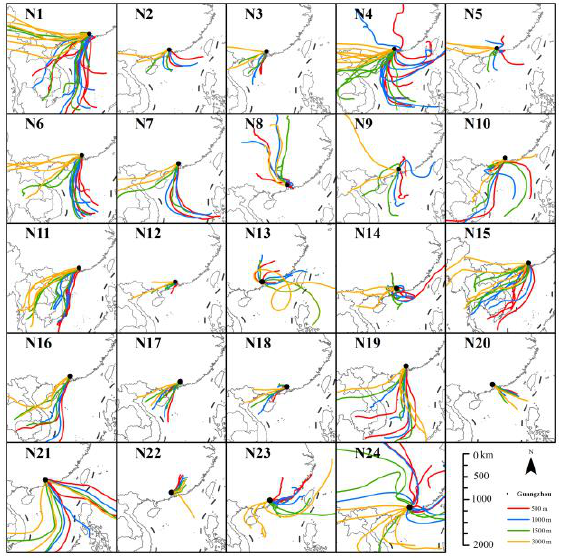
Figure 4. Water vapor trajectories for each rain event.